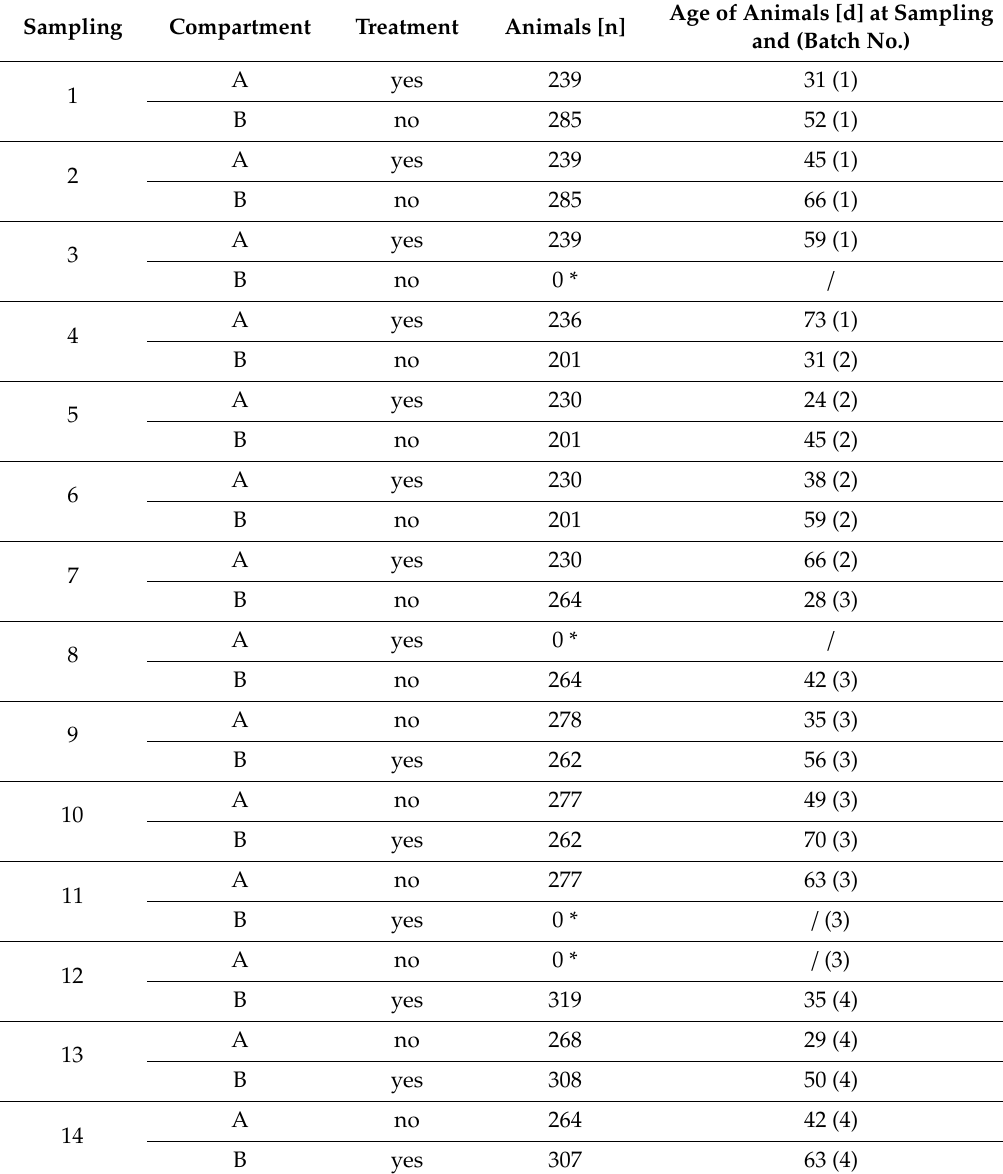
Table 1. Treatment status, animal numbers and batch numbers in compartments A and B.